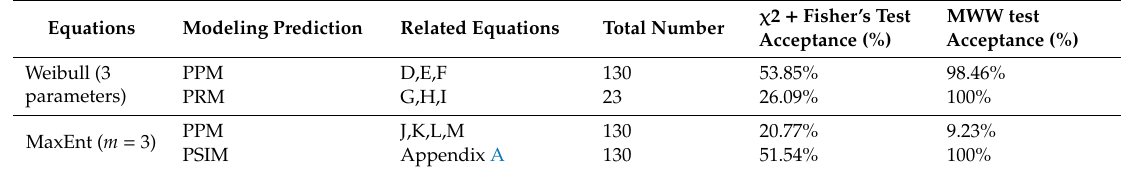
Table 10. The statistics of di ff erent evaluation methods for MaxEnt distribution and the three-parametric Weibull function derived from the 130 stands used for goodness-of-fit